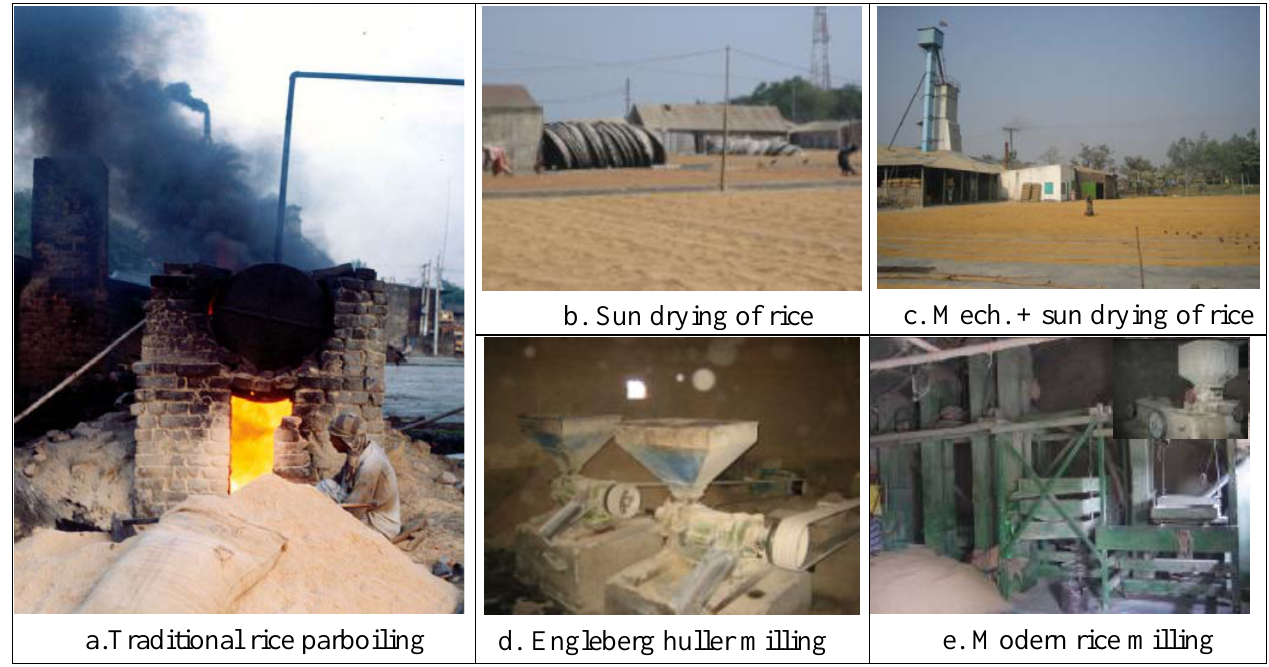
Photo 1. Showing different rice processing operations in